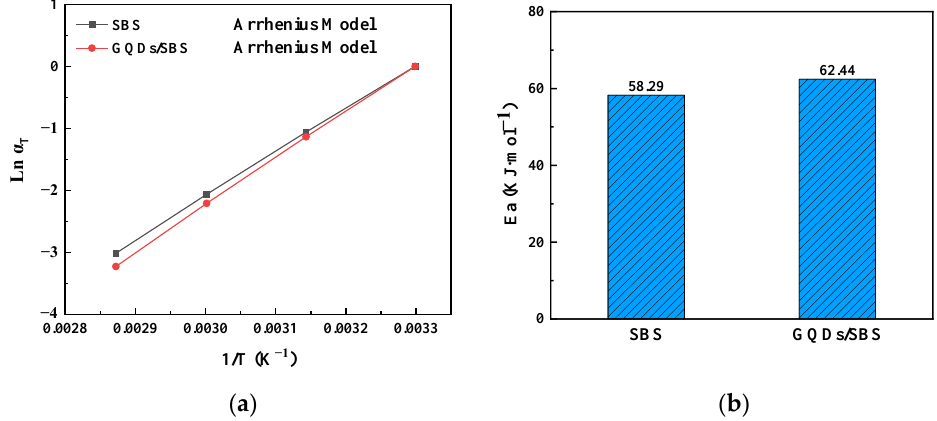
Figure 8. ( a ) Shifting factor versus temperature and ( b ) activation energy for GQDs/SBS composite- modified asphalt and SBS-modified asphalt.